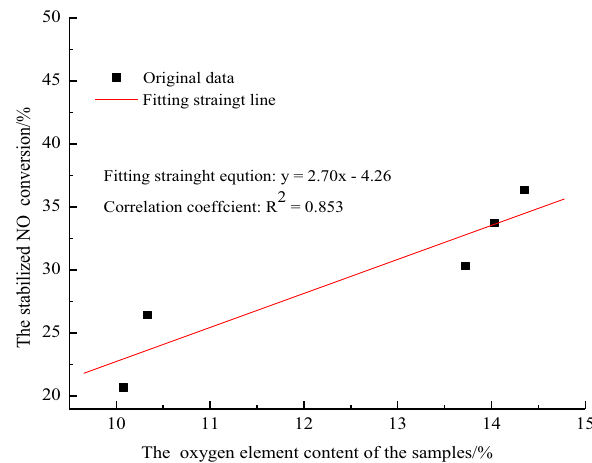
Fig. 5 Relationship between oxygen element content and stabilized